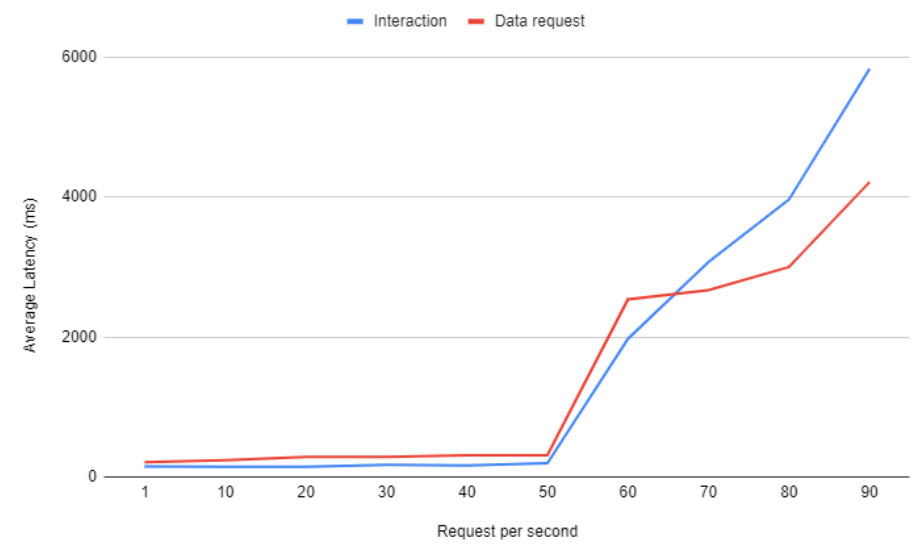
Figure 13. Response latency when increasing the load of the system.